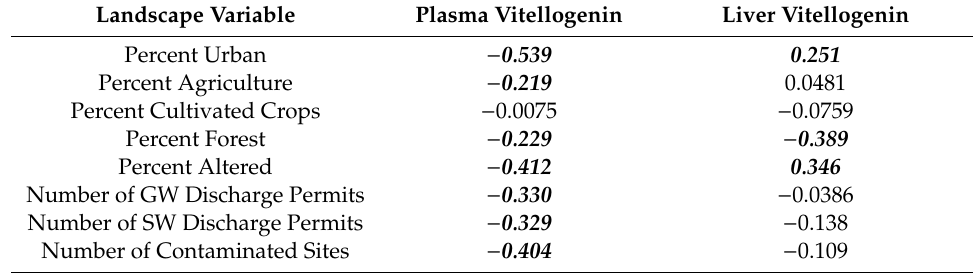
Table 3. Spearman rank-order correlations among fish health metrics including intersex severity, plasma vitellogenin and liver vitellogenin and select landscape variables. These data include river and reservoir sites ( N = 113 male fish at nine sites). Values in bold / italics are statistically significant ( p ≤